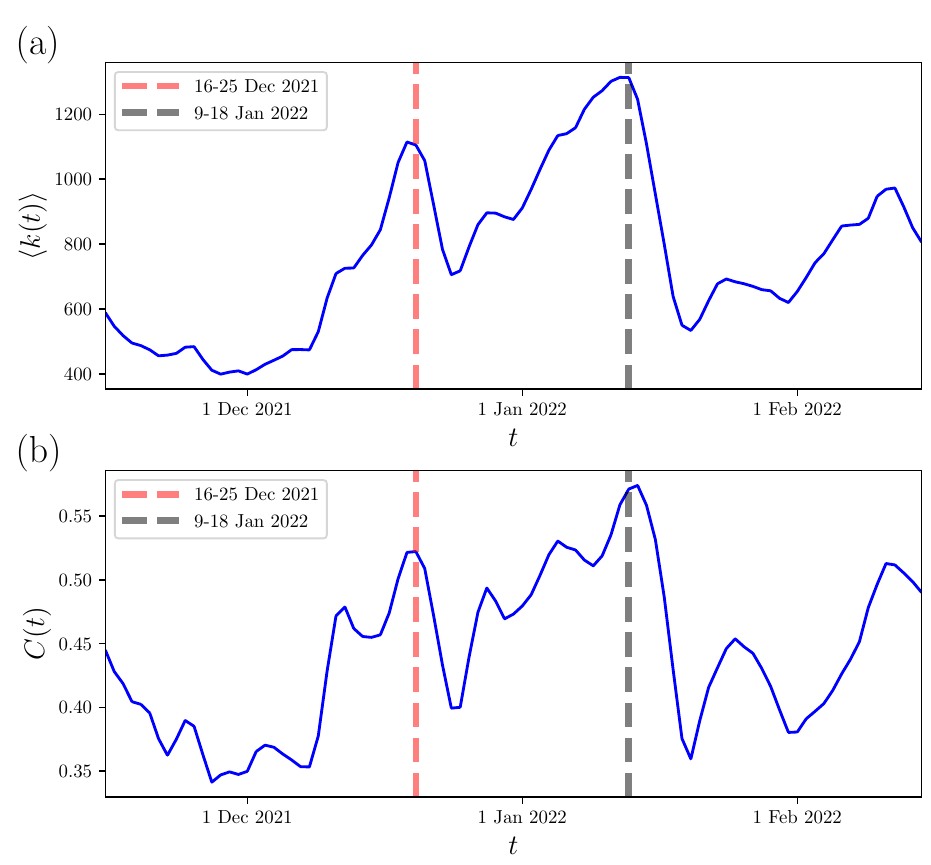
k ( t ) and ( b ) the global clustering coefficient C ( t ) for each evolving (cid:104) (cid:105)